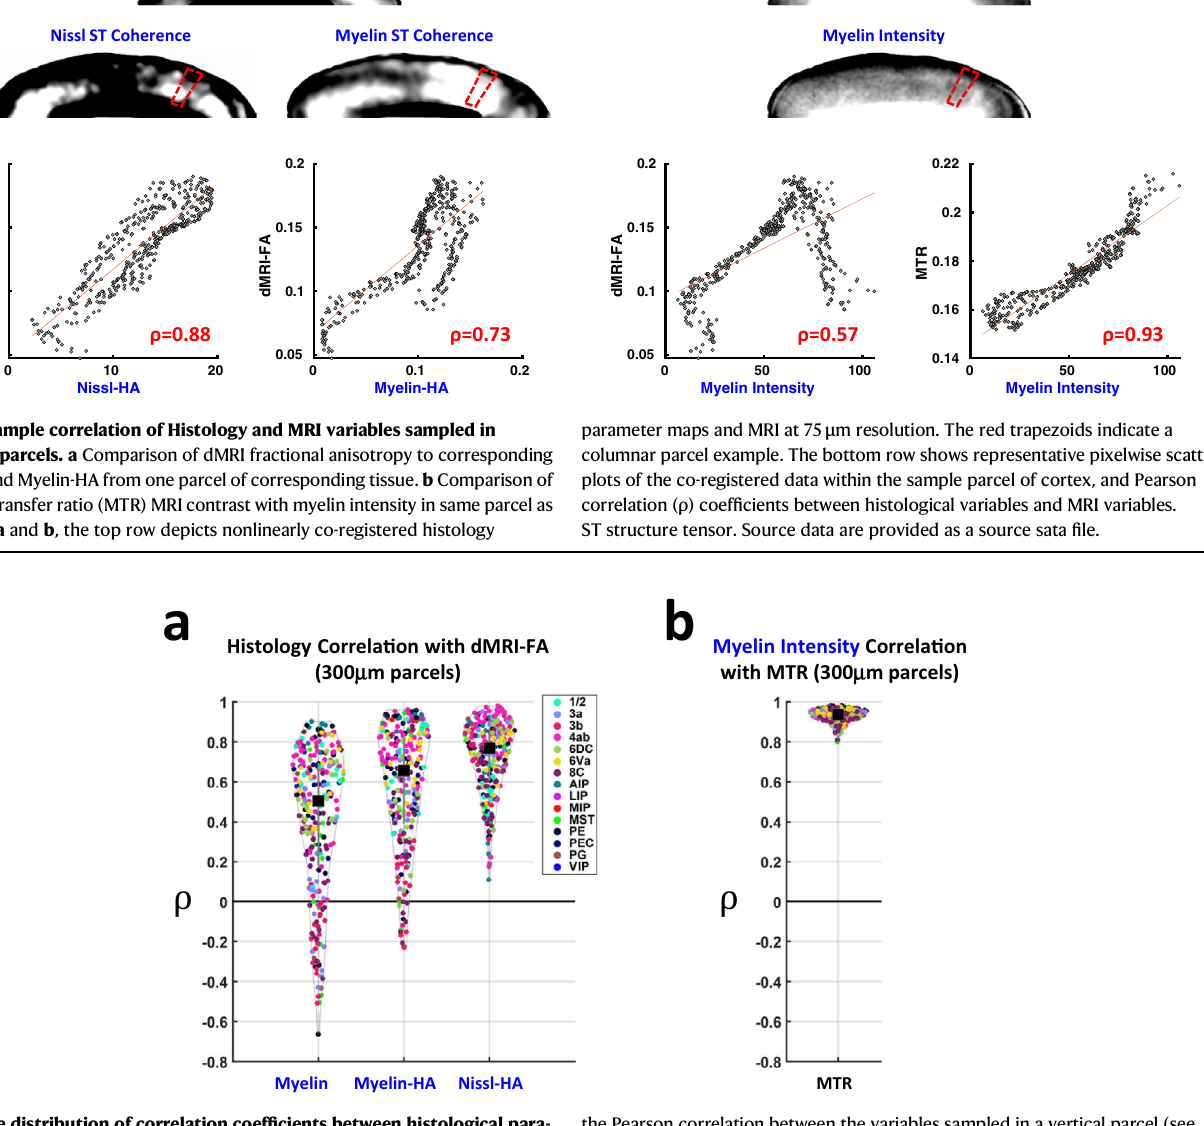
the Pearson correlation between the variables sampled in a vertical parcel (see Methods). Colors indicate the anatomical region a parcel falls within. Black square shows median value and vertical gray bars show lower and upper quartiles. ρ indicatesPearsoncorrelationcoef fi cient.Eachparcelisoneof n =393independent samples from the marmoset cortex, spanning 18 distinct histological sections. Source data are provided as a source data fi